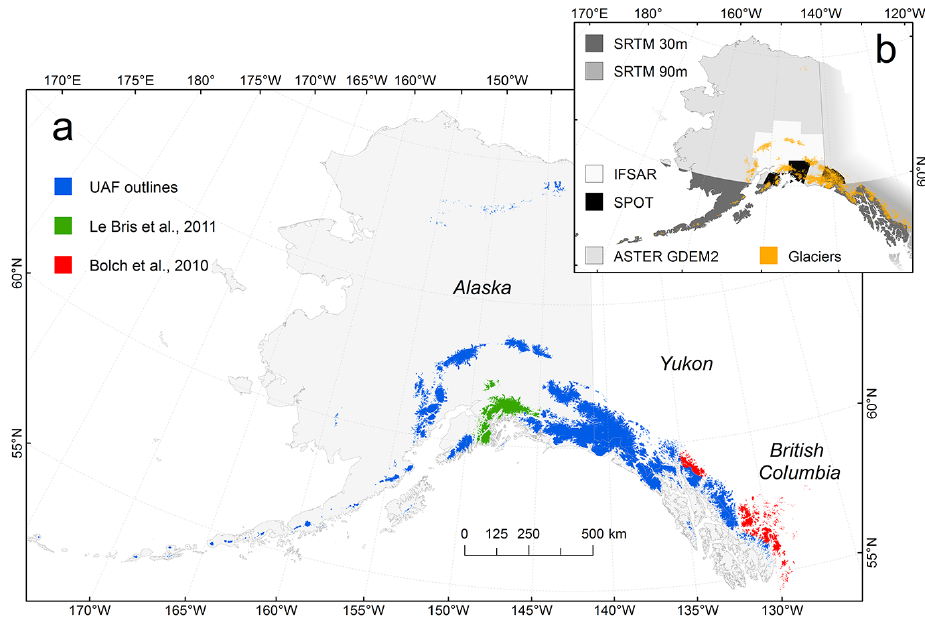
Fig. 1. The study area comprising glaciers of Alaska and adjacent Canada. (a) The three main outline sources marked in colors. (b) The DEM products used within the